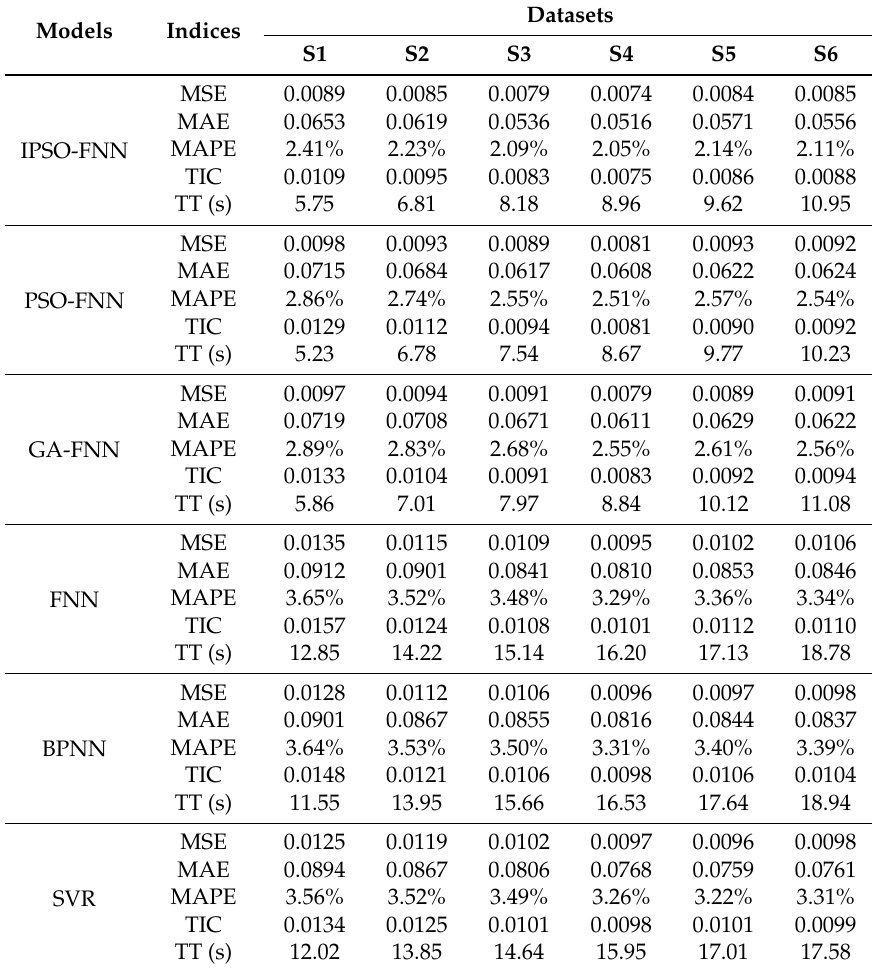
Table 3. Experiment results of six testing datasets based on different